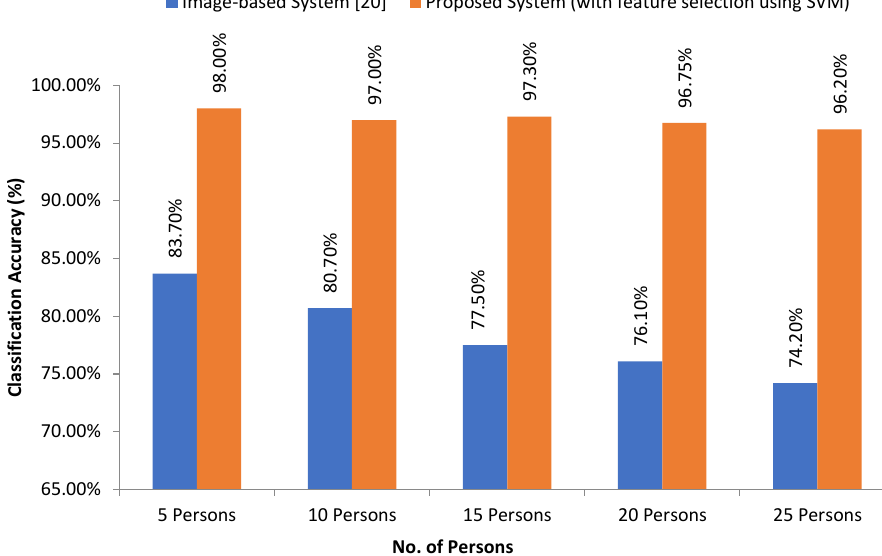
Figure 18. Comparison of accuracy for different classification algorithms with and without FS.